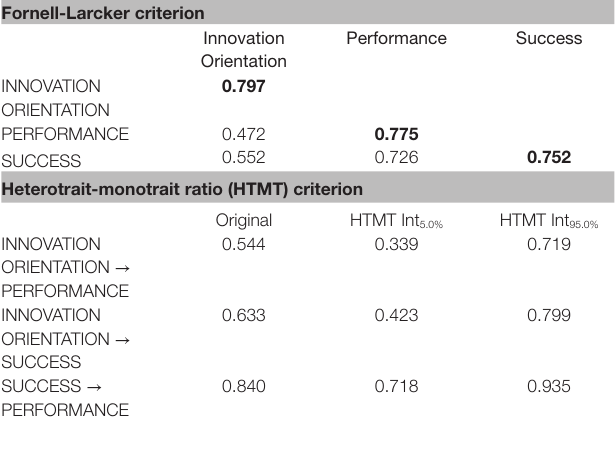
TABLE 8 | Discriminant validity analysis – second-order model.